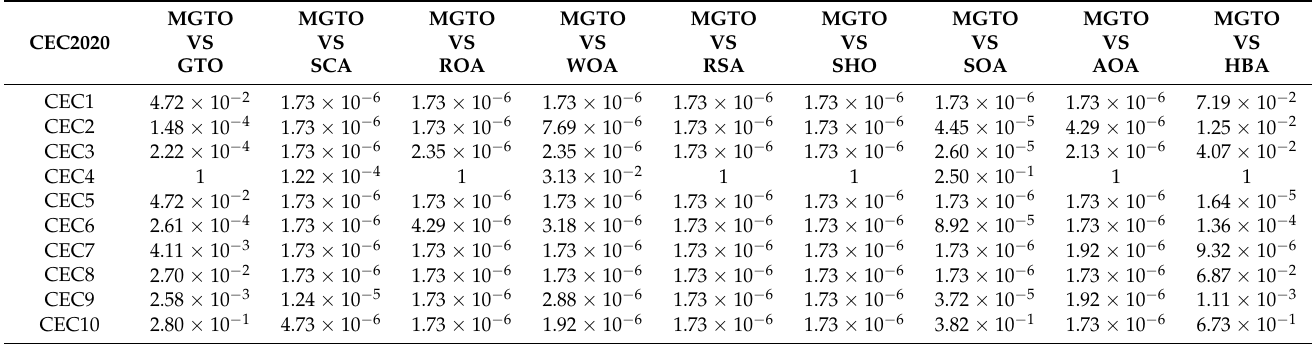
Table 8. CEC2020 Experimental Results of Wilcoxon Rank-Sum Test on Benchmark